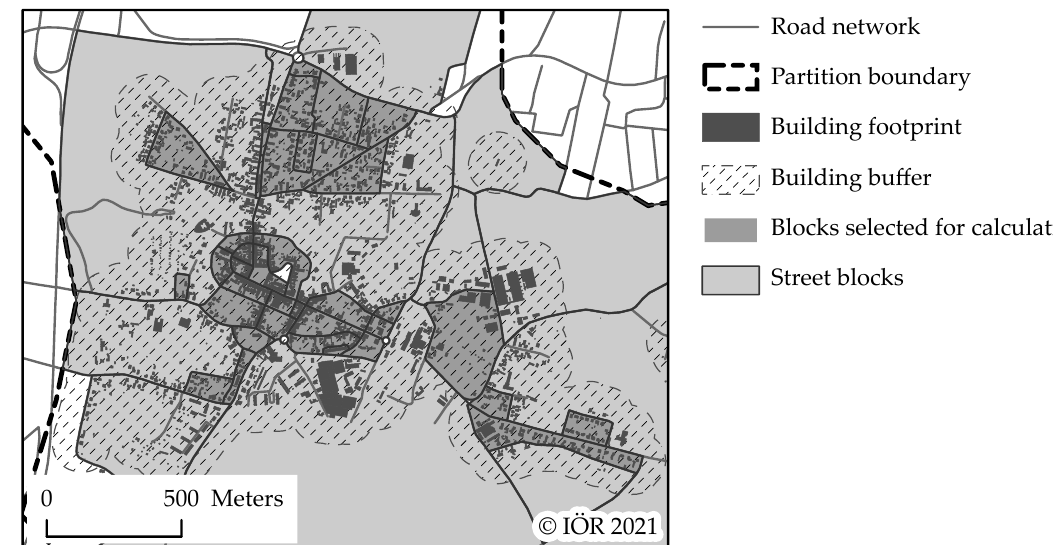
Figure 4. The figure shows how the reference area is determined for calculating the building coverage ratio, here using as an example the settlement of Ortrand in Brandenburg. The light grey areas with dark grey borders are the street blocks derived from the road network. The majority of the street blocks are very large at the edge of the settlement and only a small share of them can be assigned to the actual settlement area. In order to consider only those street blocks that lie within the settlement area, all buildings are therefore enclosed by a 100-metre buffer (hatched areas). Street blocks that lie within this buffer area and contain at least 20 buildings or parts of buildings are used for the calculation (dark grey areas). ( source : own illustration based on data from ATKIS ® Base-DLM © Geobasis-DE/BKG